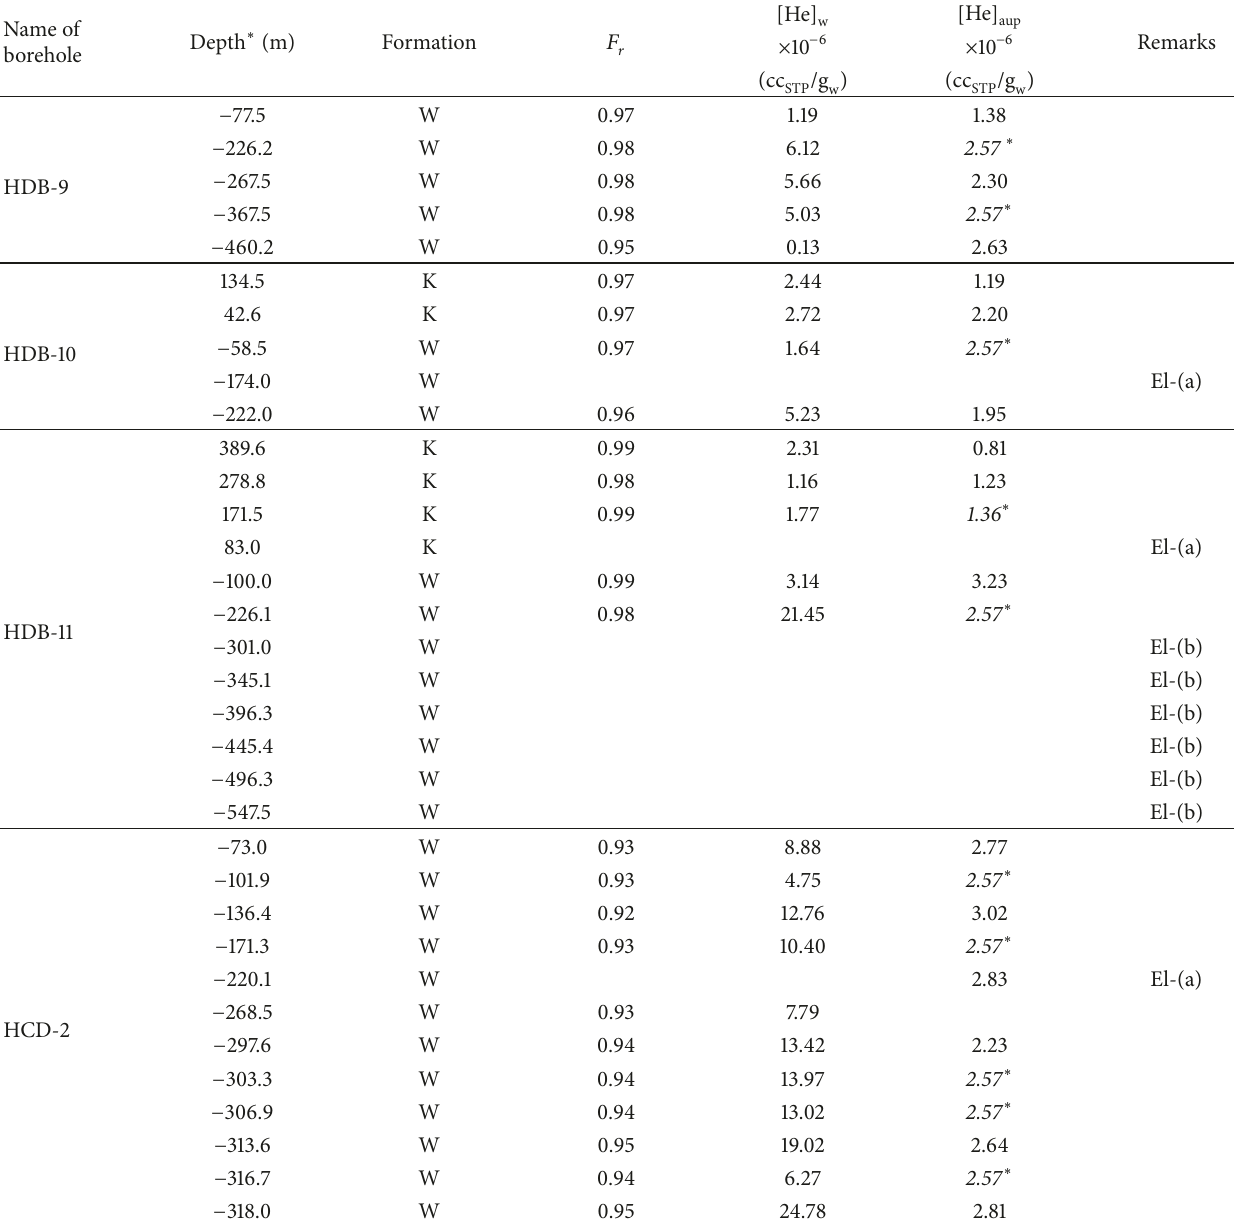
Table 3: Comparison of [ He ] accumulation rate of 4 He by radiogenic effects (calculated in Section 5.2.2) and time (1.0 million